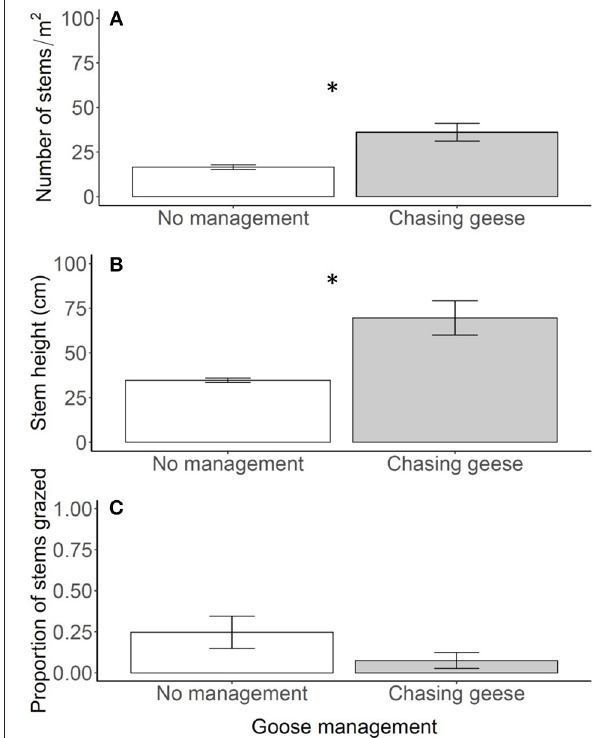
FIGURE 4 | Reed density (A) , stem height above the water (B) and proportion of grazed stems (C) in the control plots in 2012 (no management) and 2013 (chasing geese). In 2013 geese were actively chased away, whereas they could forage undisturbed in 2012. Data are means ± SE, n = 6. An asterisk indicates a significant difference between years at P <